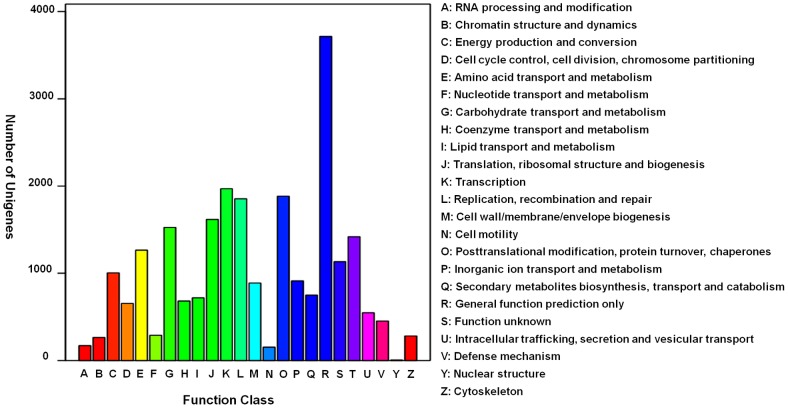
COG function classification of the foliar transcriptome of C. amaranticolor.Out of 62,482 nr hits, 24,147 sequences have a COG classification among the 24 categories.